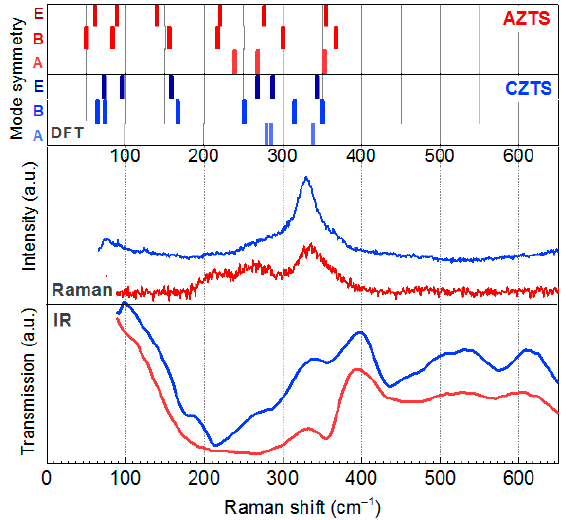
Figure 10. DFT calculated phonon frequencies of AZTS and CZTS kesterite lattices (upper part of the figure) in comparison with the representative experimental Raman and IR spectra of AZTS and CZTS NCs from this work. Note that all modes (A-, B-, and E-symmetry) are Raman-active, while only B- and E-symmetry modes are IR-active.